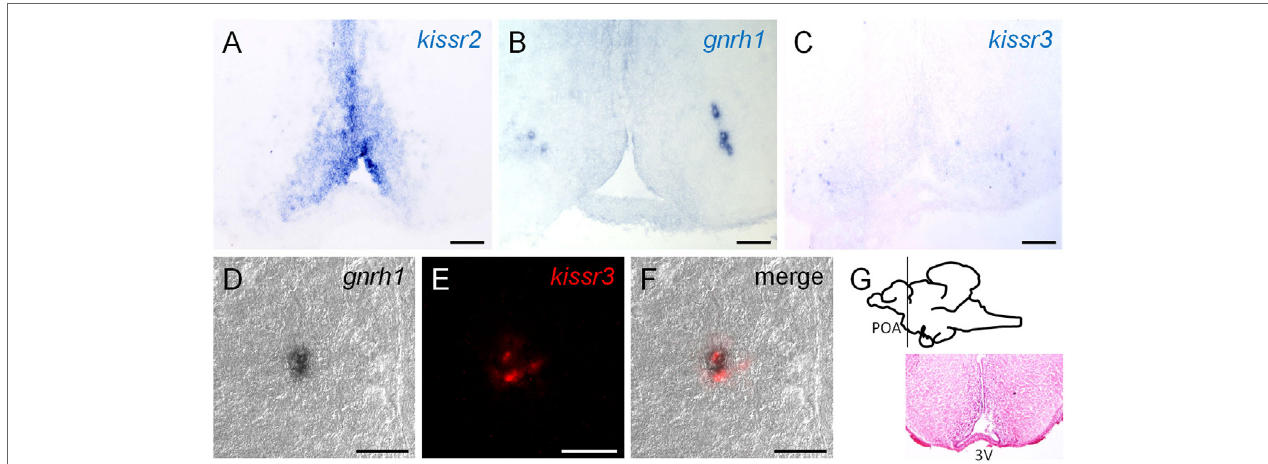
FigURe 5 | (A–C) Localization of kissr2 expressing cells, Gnrh1 neurons, and kissr3 -expressing cells at pre-optic area (POA), respectively. Scale bars, 100 µm. (D–F) Double-label in situ hybridization at the POA region. Scale bars, 30 µm. (D) Differential interference contrast images of Gnrh1 neurons. (e) Red fluorescence indicate the kissr3 mRNA. (C) Merged image of (e,F) and indicate that Gnrh1 neurons co-expressed kissr3 mRNA. (g) Sagittal view of the chub mackerel brain. Planes of the ventral POA region are visualized by hematoxylin–eosin staining. Modified from Ref. (38), by permission of Oxford University